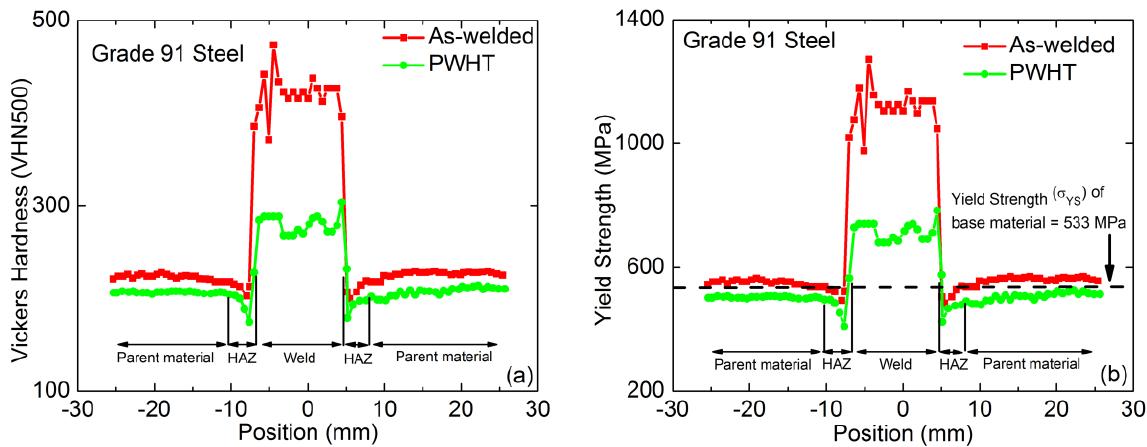
Figure 3. Vickers microhardness ( a ); and yield strength profile ( b ) of welded Grade 91 steel. Position “0” indicates the center of the weld.